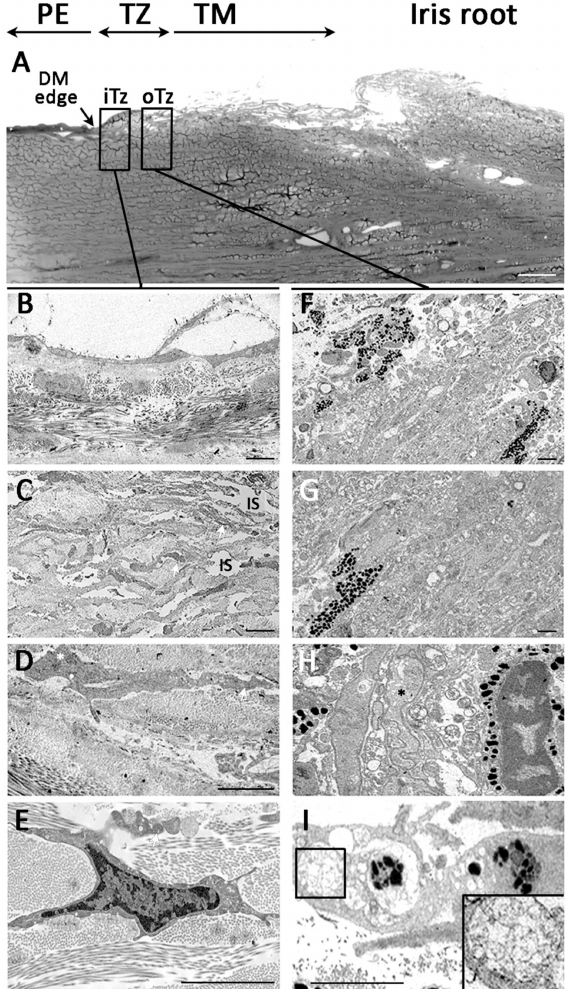
Figure 6. Ultrastructural morphology under transmission electron microscopy. ( A ) Overview picture illustrates posterior limbus with peripheral endothelium (PE) with DM edge, transition zone with inner and outer TZ, followed by trabecular meshwork (TM) and iris root. Inner TZ. ( B,C ) Cells in the loosely arranged stromal matrix with numerous interstitial spaces (IS). ( D,E ) The cells had high nuclear / cytoplasmic ratio and with loose chromatin and pronounced nucleoli (white asterisk in C). Outer TZ. ( F,G ) A mix of non-pigmented and pigmented cells in a closely packed matrix. ( H ) Cells containing cytoplasmic granules with pigmentation adjacent to highly convoluted non-pigmented cells. ( I ) Cell with phagosomes containing irregular deposits (magnified image in inset). Abbreviations: iTZ: inner TZ; oTZ: outer TZ; DM: Descemet’s membrane. Scale bars: 50 µ m (A); 10 µ m (B–F, I); 5 µ m